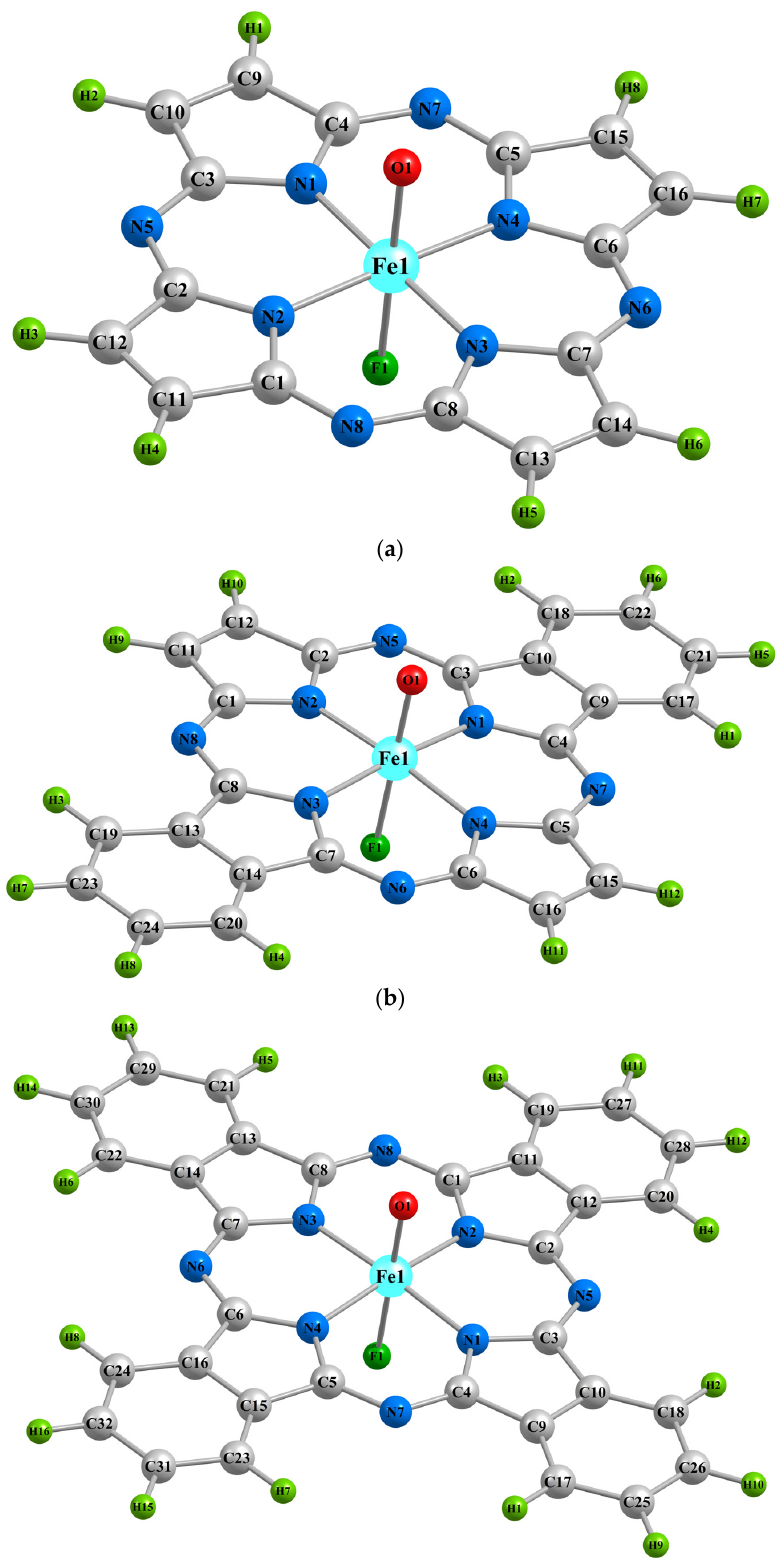
Figure 1. The images of molecular structures of the iron complexes I – III obtained as a result of quantum-chemical calculation by DFT B3PW91/TZVP: ( a ): [Fe L1 (O)F], ( b ): [Fe L2 (O)F], ( c ): [Fe L3 (O)F].